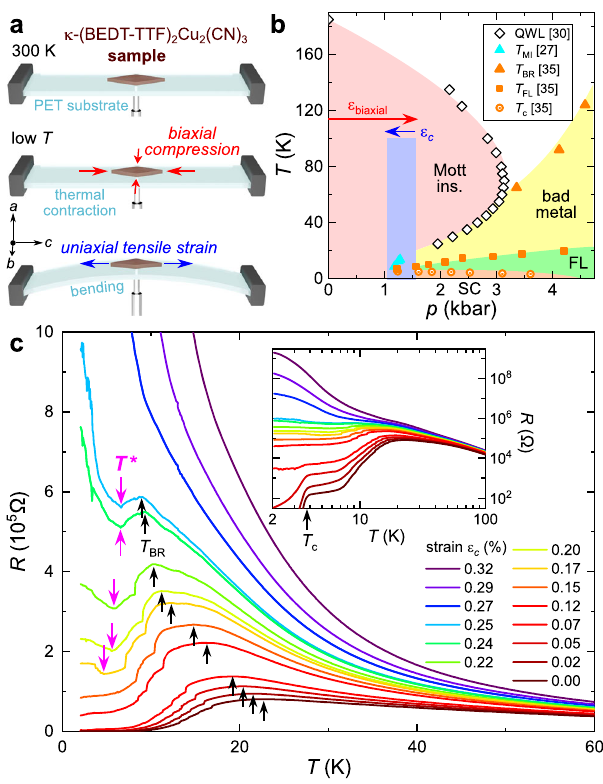
Fig. 2 | Strain-tuning of κ -(BEDT-TTF) 2 Cu 2 (CN) 3 . a , b A 140 nm thin single- crystalline fi lament of κ -(BEDT-TTF) 2 Cu 2 (CN) 3 was placed on a fl exible PET sub- strate.Coolingfrom300Kdownto T → 0imposesbiaxialcompressionoforder1 – 2 kbar to the sample due to differential thermal contraction, yielding metallic and superconducting(SC)properties(redarrowin b ).Uniaxialtensilestrain ε c alongthe c -axisis applied via bending of the substratein orderto tune from the Fermiliquid (FL) through the Mott MIT (blue arrow in b ). b Crossover and transition tempera- tures from refs. 27,30,35, as indicated. c Resistance of the biaxially compressed crystal for different ε c . Inset: SC below T c ≈ 4K for ε c =0 is evident in the log-log plot. Upon approaching the Mott state, SC is lost and the resistivity maxima at T BR shift to lower temperatures. In addition, our data reveal a reentrance of insulating behavior (magenta arrows) below T ⋆ < T BR .